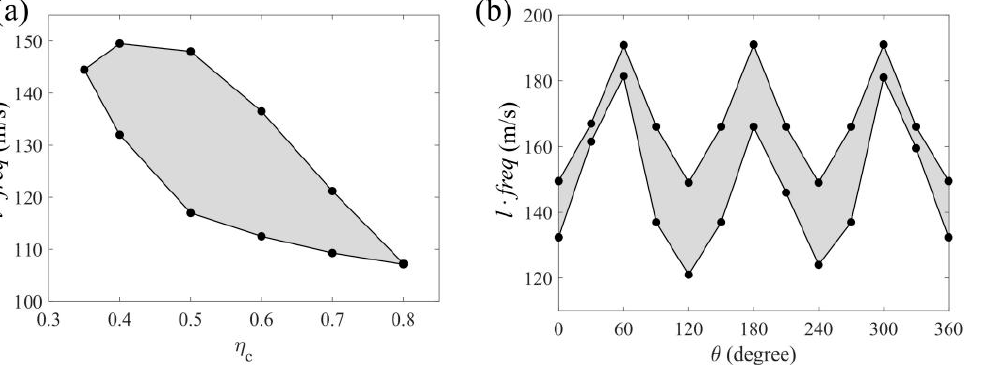
Figure 10. The effects of parameters ( a ) η c ( b ) θ on the band gaps of the primitive cell by moving P 1 in horizontal directions.